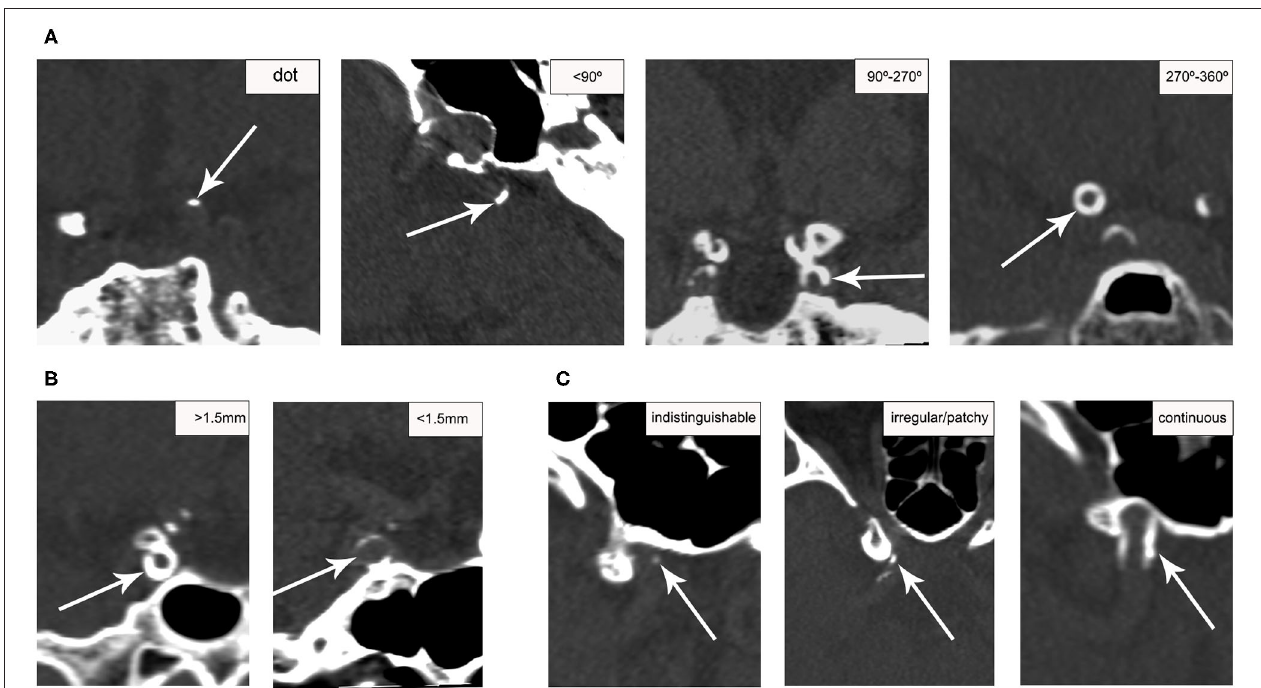
FIGURE 1 | Examples of calcification score for categorizing ICA calcification patterns. Calcification (arrows) was scored based on circularity (A) , thickness (B) , and continuity (C) on CT. Circularity and thickness were assessed on the short axis; continuity was assessed on the long axis.